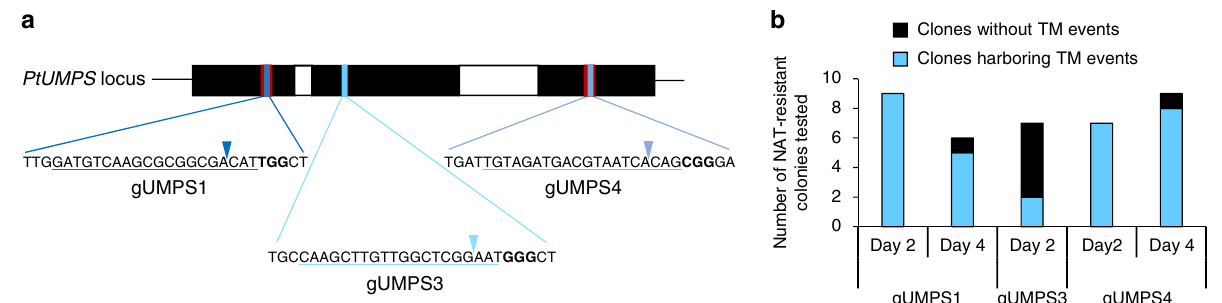
Fig. 2 CRISPR/Cas9-induced knock-out mutations at the PtUMPS locus. a Schematic representation of the position and sequence targeted by each gRNA: gUMPS1, gUMPS3, and gUMPS4. The 20-nt region of the target site is underlined and the PAM (Protospacer Adjacent Motif) is shown in bold letters. b Ef fi ciency of targeted mutagenesis induced by the delivery of the NAT resistance cassette, gRNA, and Cas9 encoding vectors into WT Phaeodactylum cells after selection on NAT containing